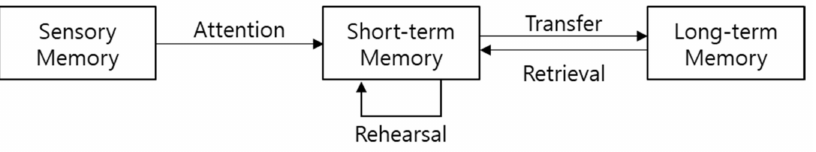
Figure 1. Atkinson and Shiffrin’s multi-store memory model which consists of sensory memory, short-term memory, and long-term memory [11].